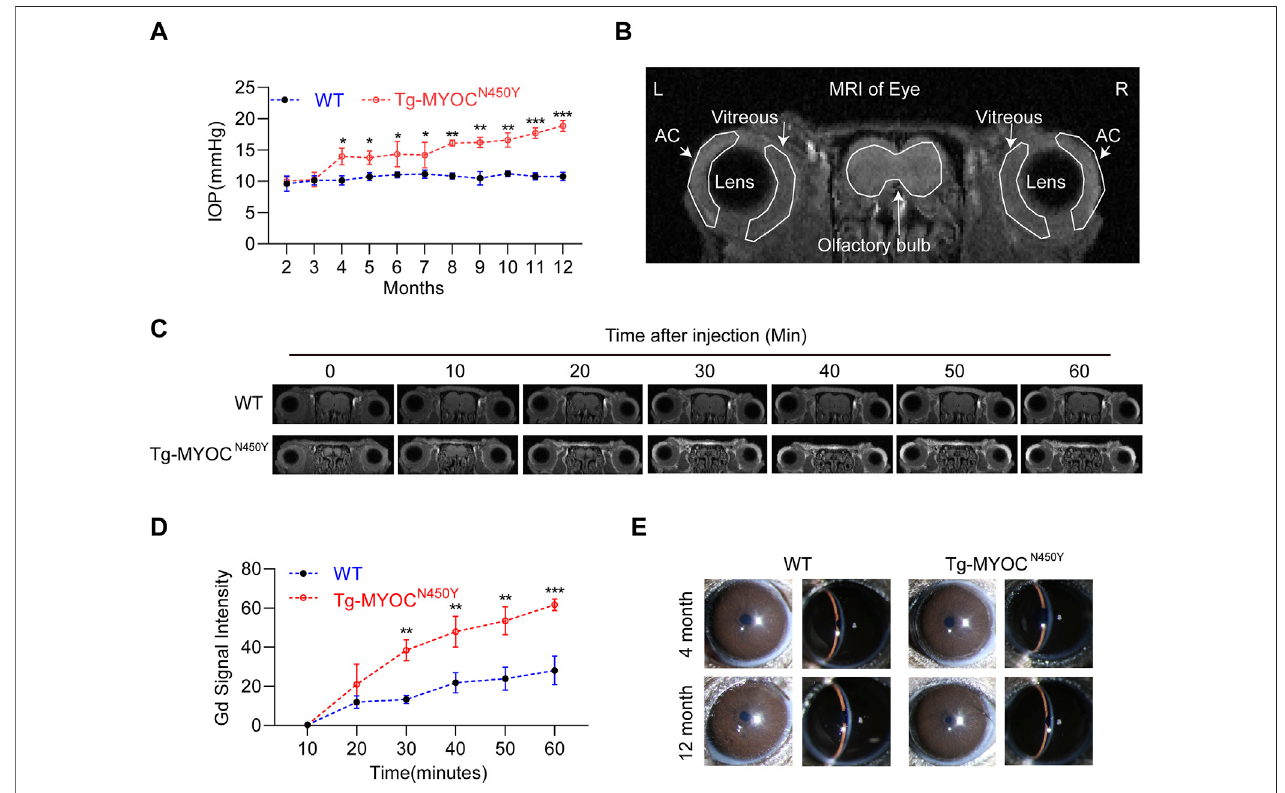
FIGURE 5 | Mutant MYOC protein leads to IOP elevation and altered aqueous humor dynamics (A) IOP was measured in Tg-MYOC N450Y and WT littermates at variousages.*, p < 0.05;**, p < 0.01;***, p < 0.001. (B) RepresentativeMRimageofbasicmiceeyeanatomy.AC,anteriorchamber. (C) Gd-enhancedMRimages from WT littermates and Tg-MYOC N450Y mice at age of 8 months. (D) Pixel intensity wasevaluated by Image J software in AC angle after Gd-DTPA injection. **, p < 0.01; ***, p < 0.001. (E) Slit lamp examination of WT and Tg-MYOC N450Y mice at various ages.